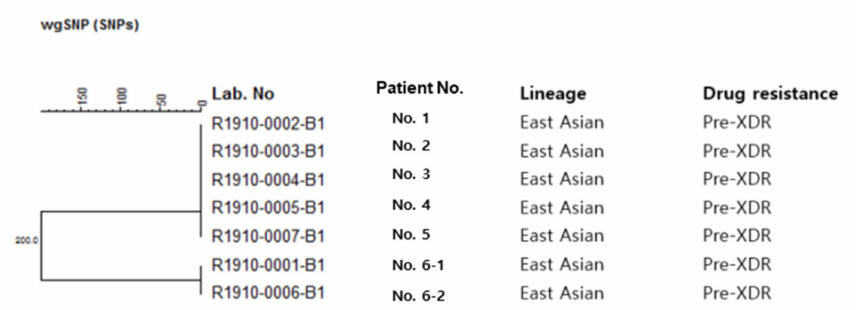
Figure 1. Phylogenetic tree of the patients.